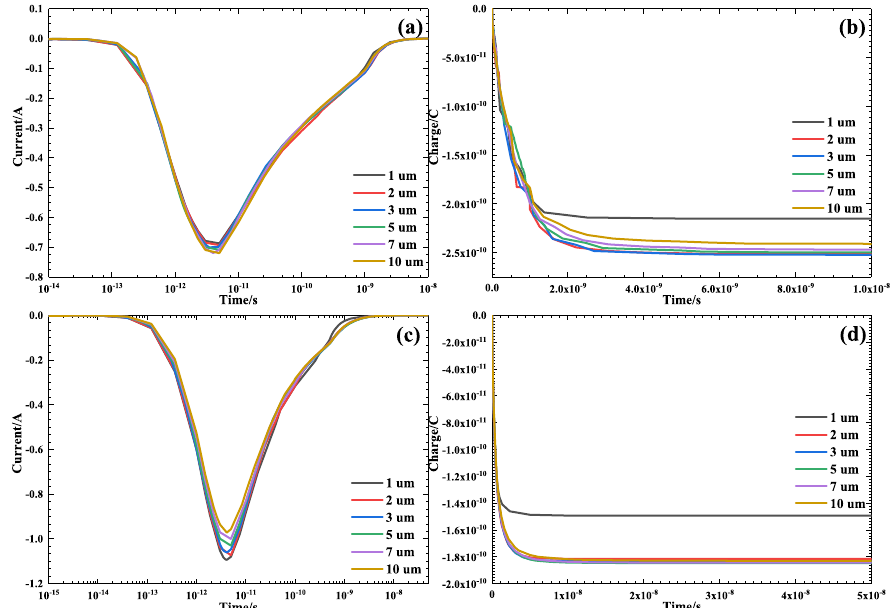
Figure 10. Change in base current and collected charge with time when heavy ions with different projected range vertically irradiate the emitter ( a , b ) and base ( c , d ) of the SiGe HBT.